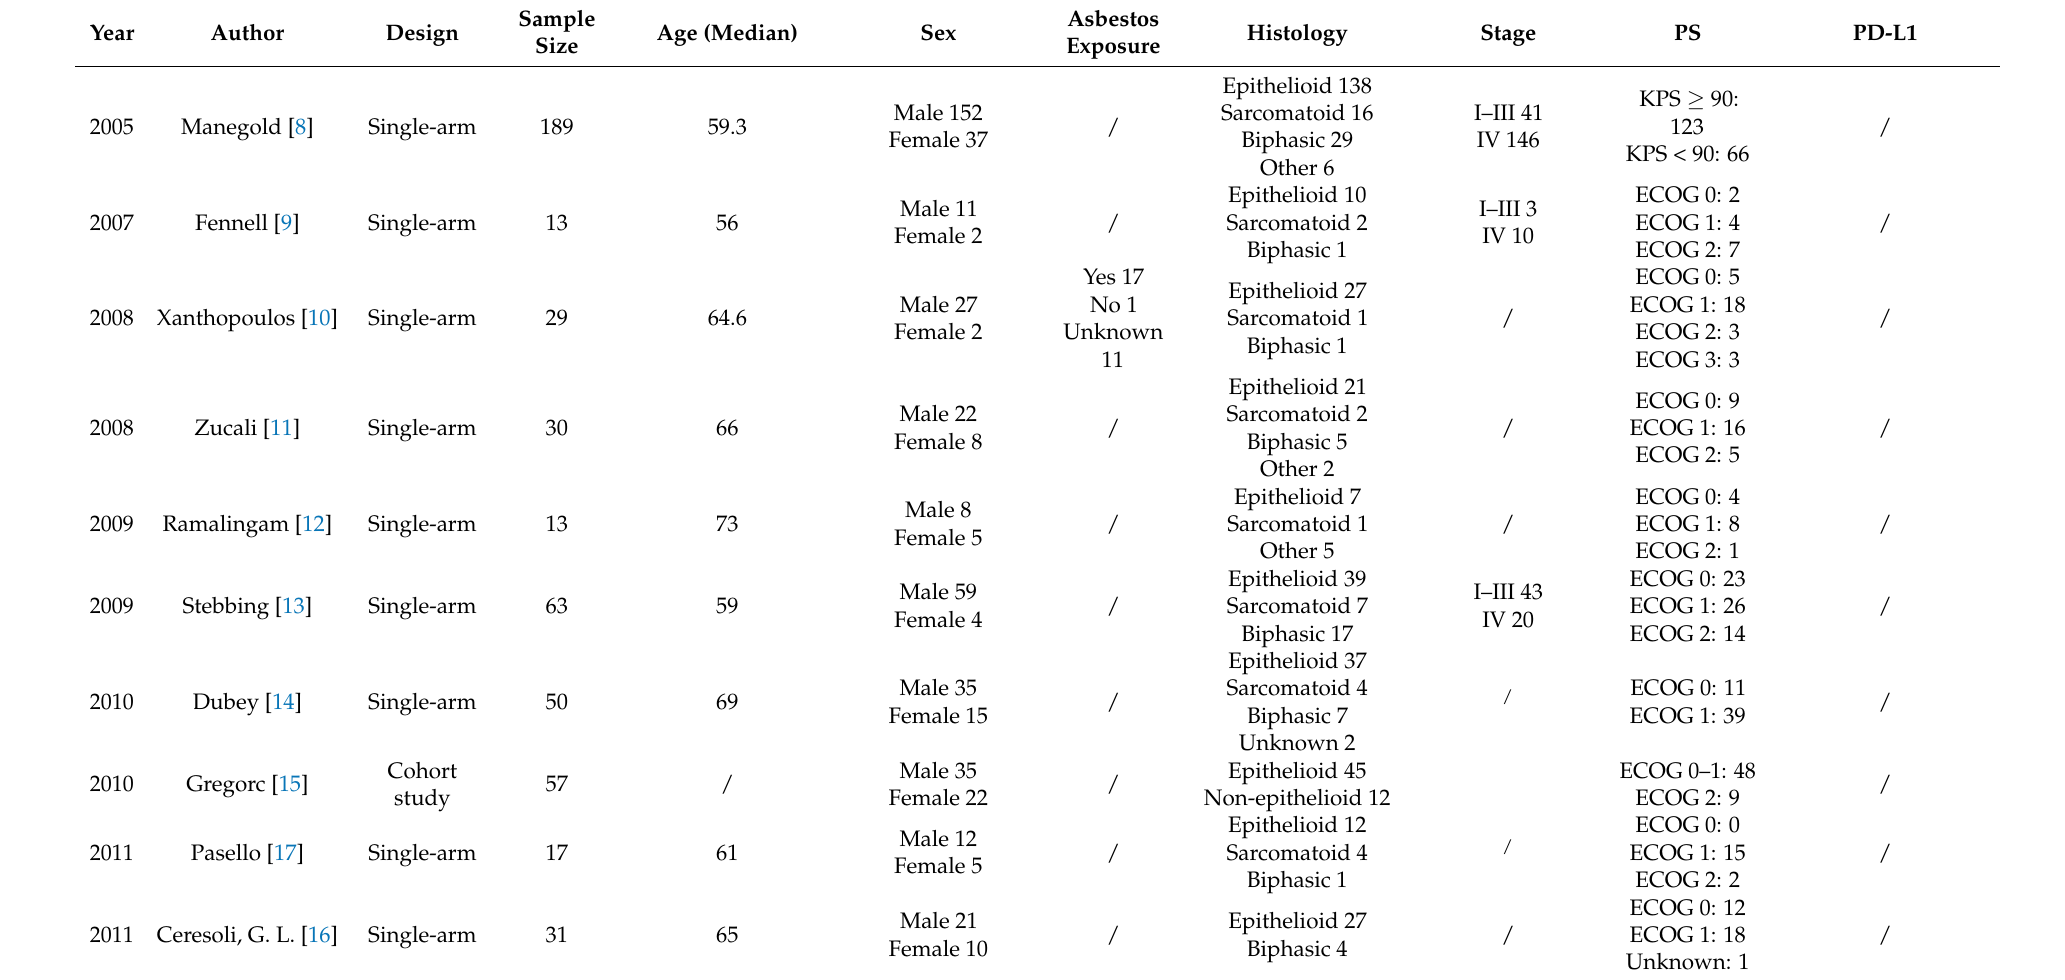
Table 2. Characteristics of patients in included